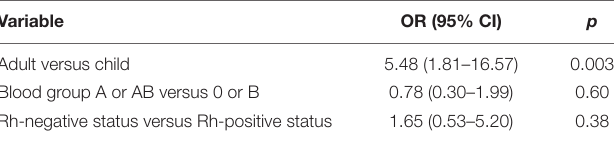
TABLE 4B | Generalized linear mixed model for risk of symptomatic SARS-CoV-2